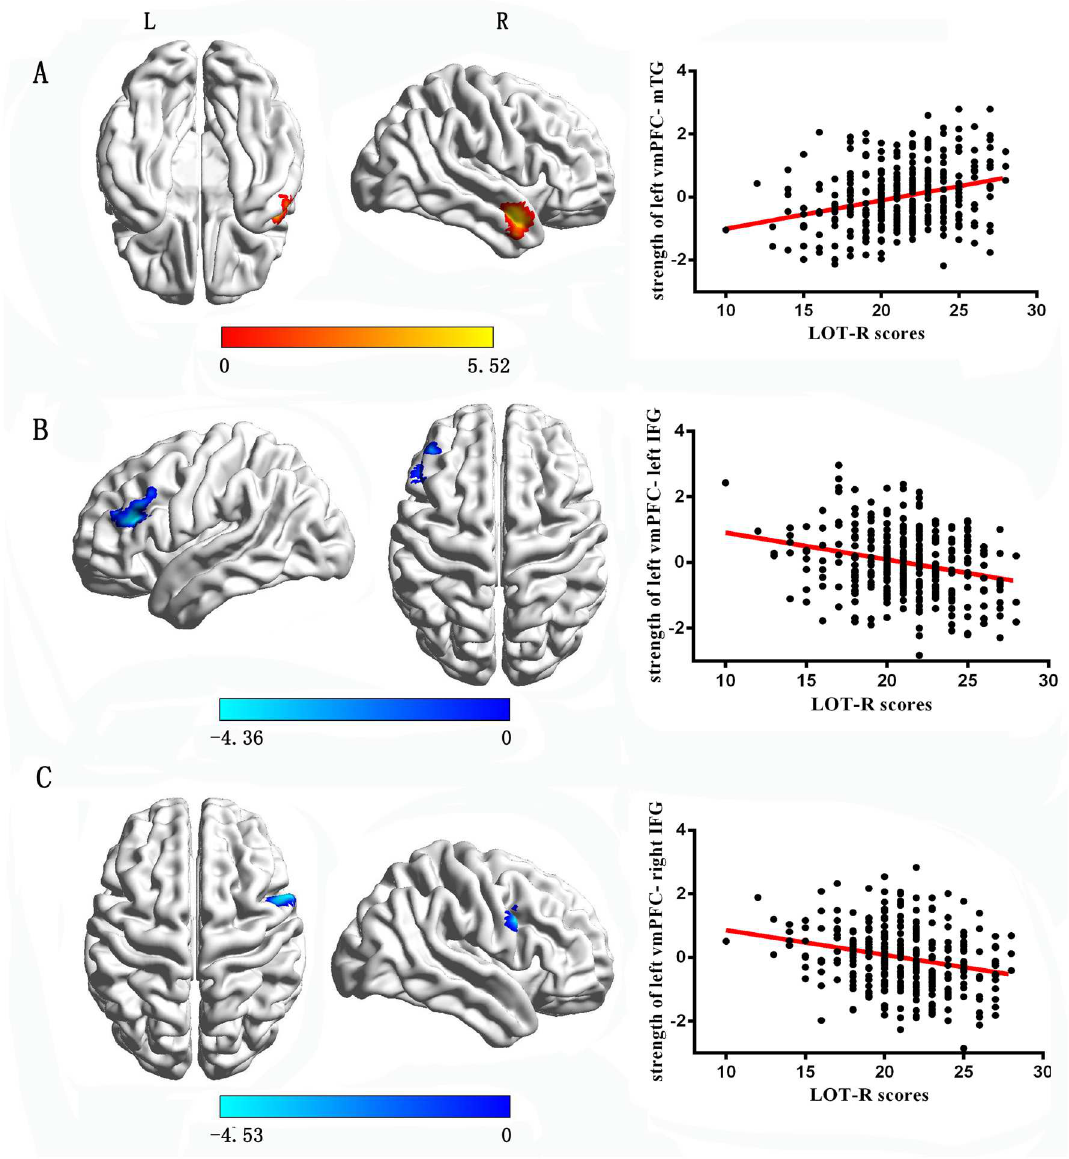
Fig 1. The correlations between optimism and the RSFC with the left vmPFC (with global signal regression). A: The regions and partial correlationsscatterplot of positive associationof optimism and the strength of RSFC betweenthe left vmPFC and mTG. B: The regionsand partial correlationsscatterplot of negative association of optimism and the strength of RSFC betweenthe left vmPFC and left IFG. C: The regions and partial correlationsscatterplot of negative association of optimism and the strength of RSFC betweenthe left vmPFC and right